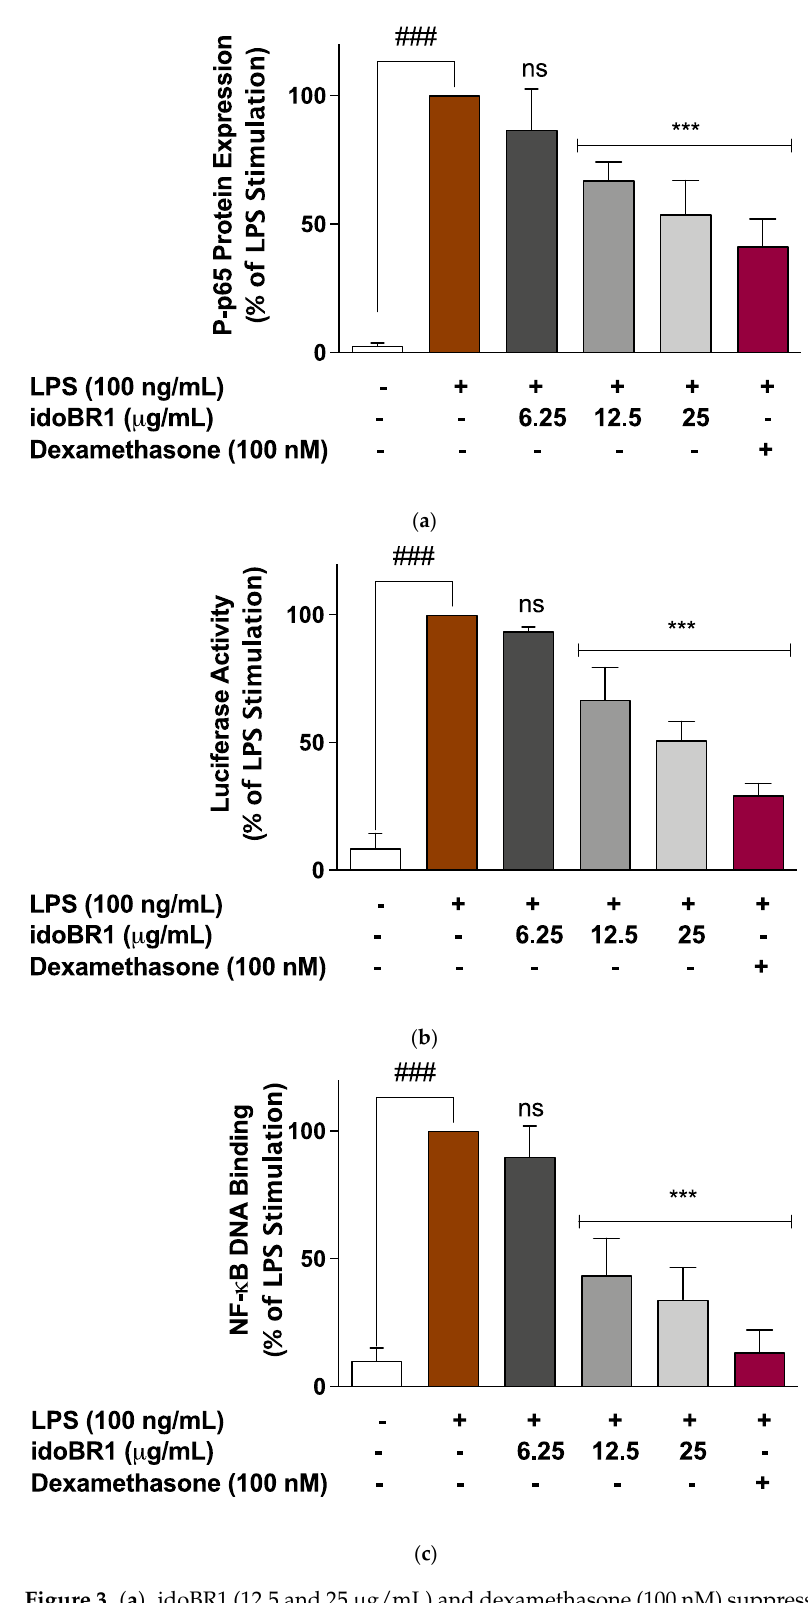
Figure 3. ( a ). idoBR1 ( 12.5 and 25 µg/mL) and dexamethasone (100 nM) suppress neuroinflammation by reducing LPS-induced increased phosphorylation of NF- κ B p65 sub-unit in BV-2 microglia. Protein levels of phospho-NF- κ B p65 (Ser536) sub-unit were determined in lysates obtained from BV-2 microglia stimulated with LPS for 60 min using ELISA. Values are expressed as mean ± SEM for three independent experiments. Data were analyzed using one-way ANOVA for multiple com- parisons with post hoc Student Newman–Keuls test. ns (not significant); *** p < 0.001 (treatment vs. LPS stimulation only); ### p < 0.001 (unstimulated cells vs. cells stimulated with LPS only). ( b ). idoBR1 ( 12.5 and 25 µg/mL) and dexamethasone (100 nM) interfered with NF- κ B activity through inhibition of NF- κ B luciferase activity in BV-2 cells transfected with pGL4.32(luc2P/ NF- κ B-RE/Hygro) vector and stimulated with LPS (100 ng/mL) for 6 h. Values are expressed as mean ± SEM for three inde- pendent experiments. Data were analyzed using one-way ANOVA for multiple comparisons with post-hoc Student Newman–Keuls test. ns (not significant); *** p < 0.001 (treatment vs. LPS stimula- tion only); ### p < 0.001 (unstimulated cells vs. cells stimulated with LPS only). ( c ) LPS-induced in- creased DNA binding by NF- κ B was reduced by idoBR1 ( 12.5 and 25 µg/mL) and dexamethasone (100 nM). Nuclear extracts from BV-2 cells stimulated with LPS (100 ng/mL) for 60 min were inves- tigated for binding to NF- κ B consensus site (5 ′ -GGGACTTTCC-3 ′ ). Values are expressed as mean ± SEM for three independent experiments. Data were analyzed using one-way ANOVA for multiple comparisons with post hoc Student Newman–Keuls test. ns (not significant); *** p < 0.001 (treatment vs. LPS stimulation only); ### p < 0.001 (unstimulated cells vs. cells stimulated with LPS only). 2.4. The Effects of idoBR1 on the Viability of LPS-Stimulated BV-2 Microglia The results of the MTT assay in Figure 4 show that pre-treatment with 6.25, 12.5, and 25 µg/mL of idoBR1, followed by stimulation with LPS for 24 h, did not reduce the viabil- ity of the BV-2 microglia.